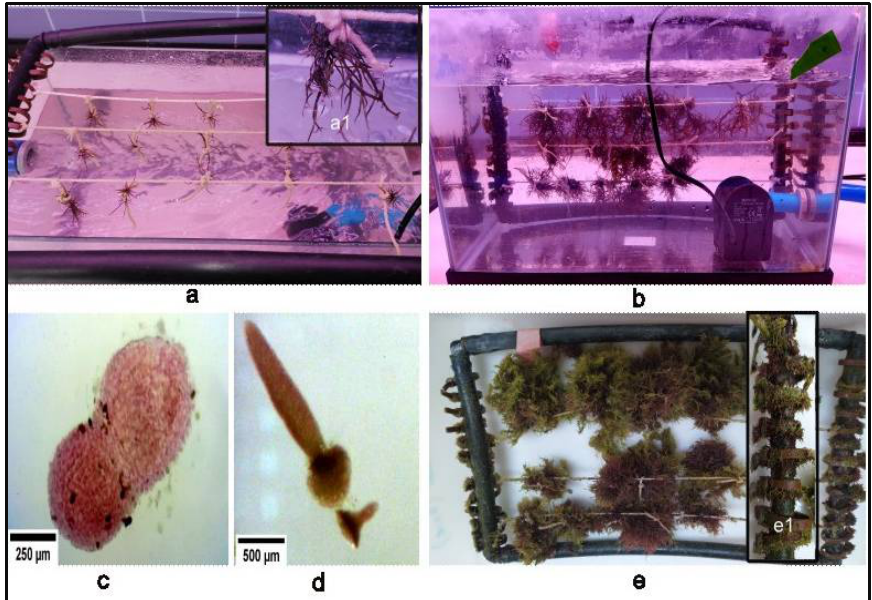
Figure 5. Aquarium culture of Gracilaria gracilis with both in artificial seawater and ES medium. ( a ) Thalli at the beginning of the culture in aquarium. ( a1 ) Detail of the sporophyte. ( b ) Sporophytes (2n) after 63 days of culture. ( c ) Basal disc developed in a new gametophyte (n) after 84 days in culture. ( d ) Emerging frond of a new gametophyte (n) after 96 days in culture. ( e ) Culture after 144 days. ( e1 ) Detail of developed gametophytes attached to the culture system.